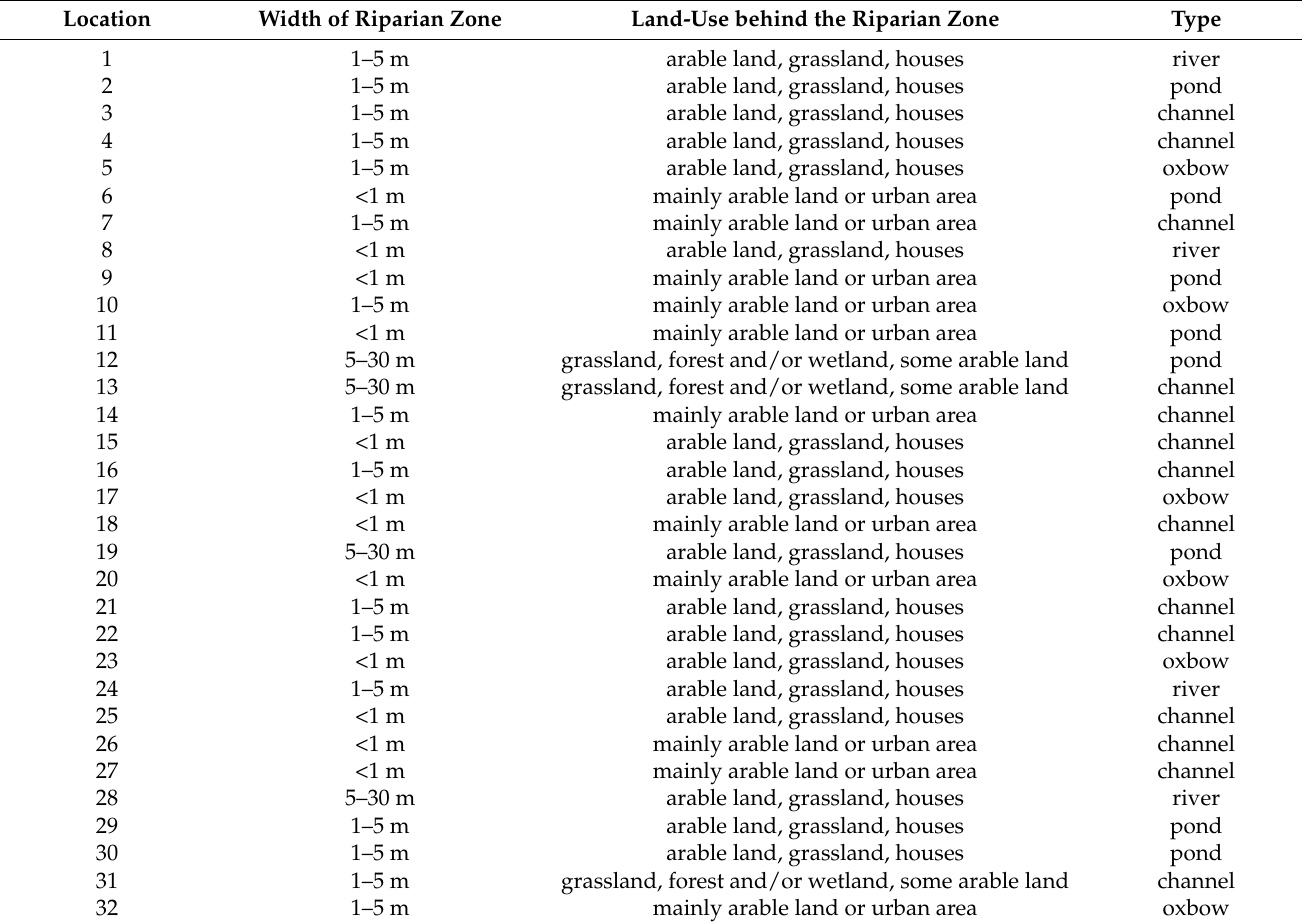
Table 1. Characteristics of the catchment area of specific waterbodies. Width of the riparian zone, where woody or herbaceous wetland vegetation is thriving and prevailing land-use behind the riparian zone is